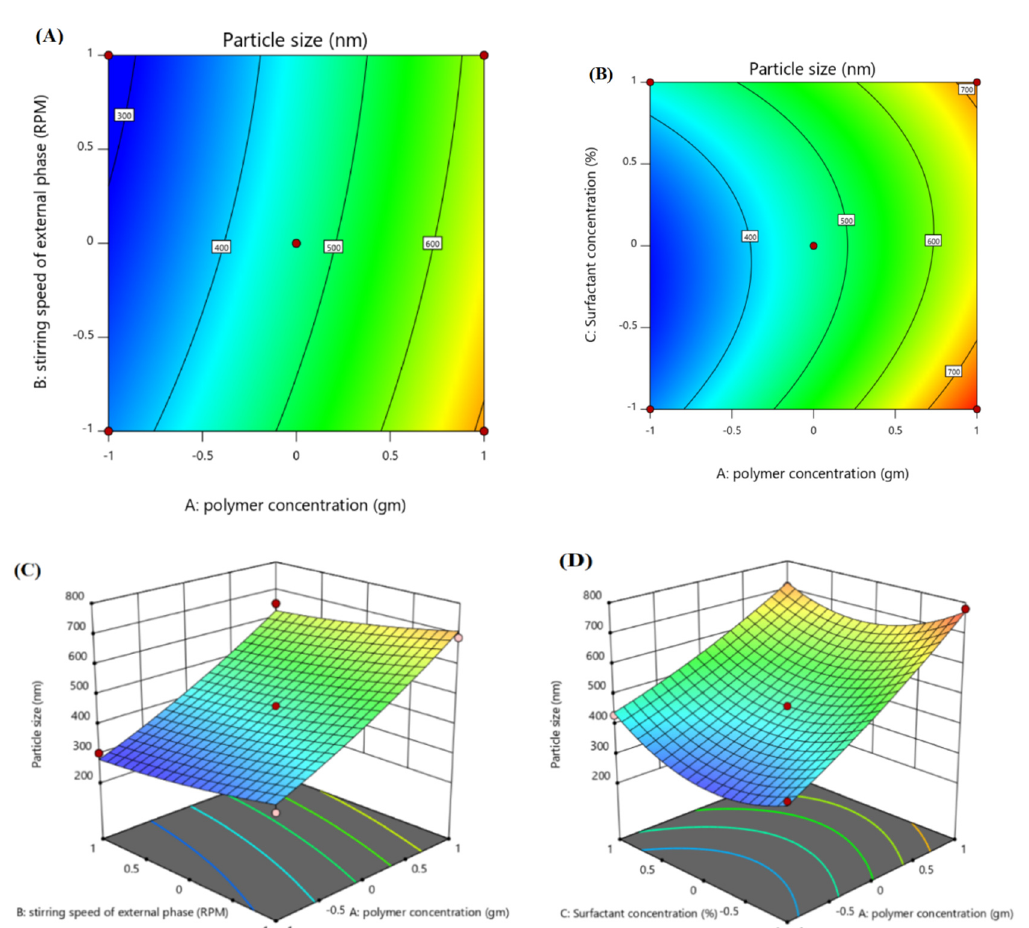
Figure 2. Contour surface plots showing the effect of independent variables (factors) on the particle size (Y1) of optimized ACR-PCL-NPs formulation. ( A ) Impact of polymer concentration and stirring speed on particle size, ( B ) impact of polymer concentration and surfactant concentration on particle size) and 3D plots, ( C ) impact of polymer concentration and stirring speed on particle size, ( D ) impact of polymer concentration and surfactant concentration on particle size.